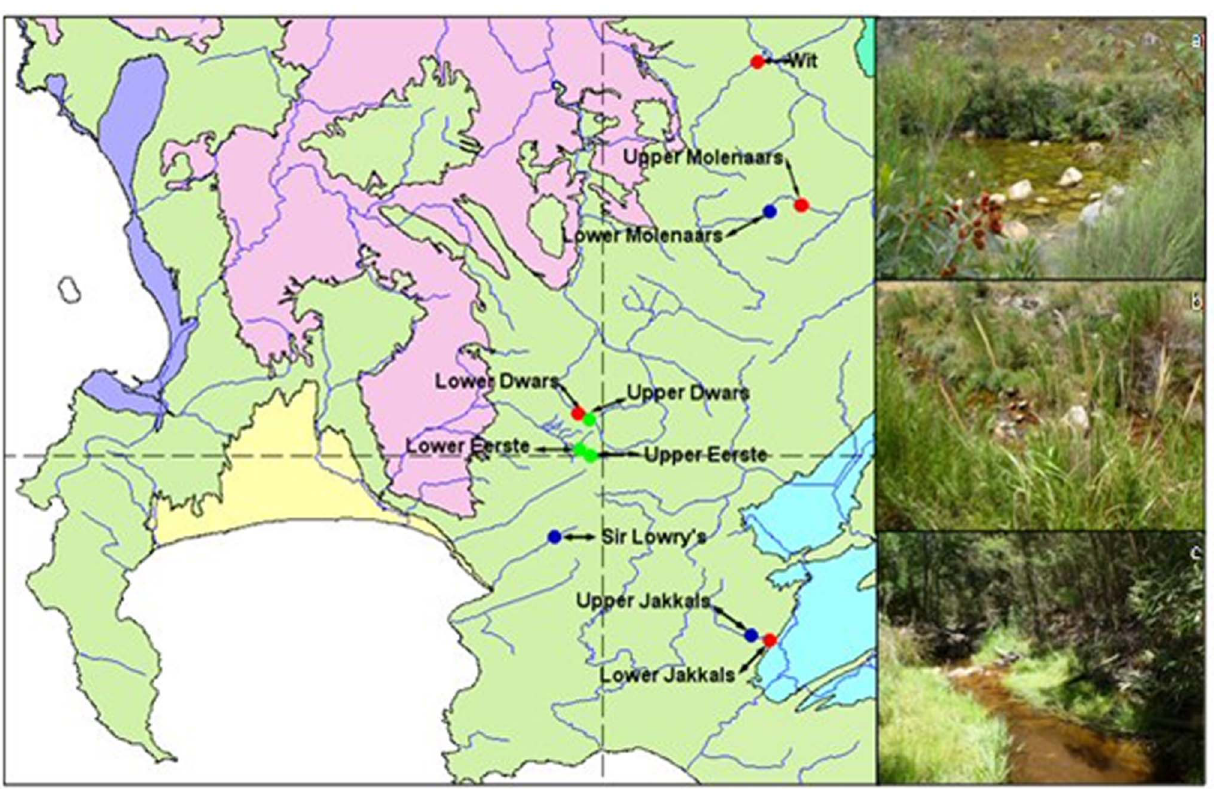
Figure 2. Location of sampling sites with invaded sites indicated in red, cleared sites in blue and pristine sites in green. 2a: Natural riparian vegetation at the lower Eerste River site. 2b: Cleared riparian zone from the Sir Lowry’s and 2c: Riparian zones invaded by Acacia mearnsii at the lower Jakkals River site.